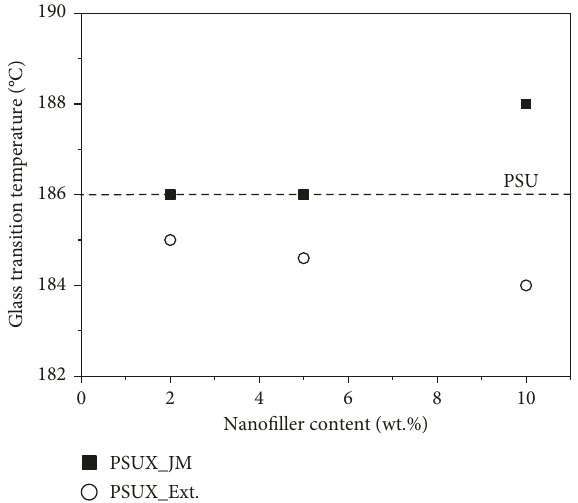
Figure 2: Glass transition temperatures collected by DSC from the second heating scan of neat PSU (dotted line), PSU_Ext ( ○ ), and PSU_JM ( ■ ) as a function of alumina